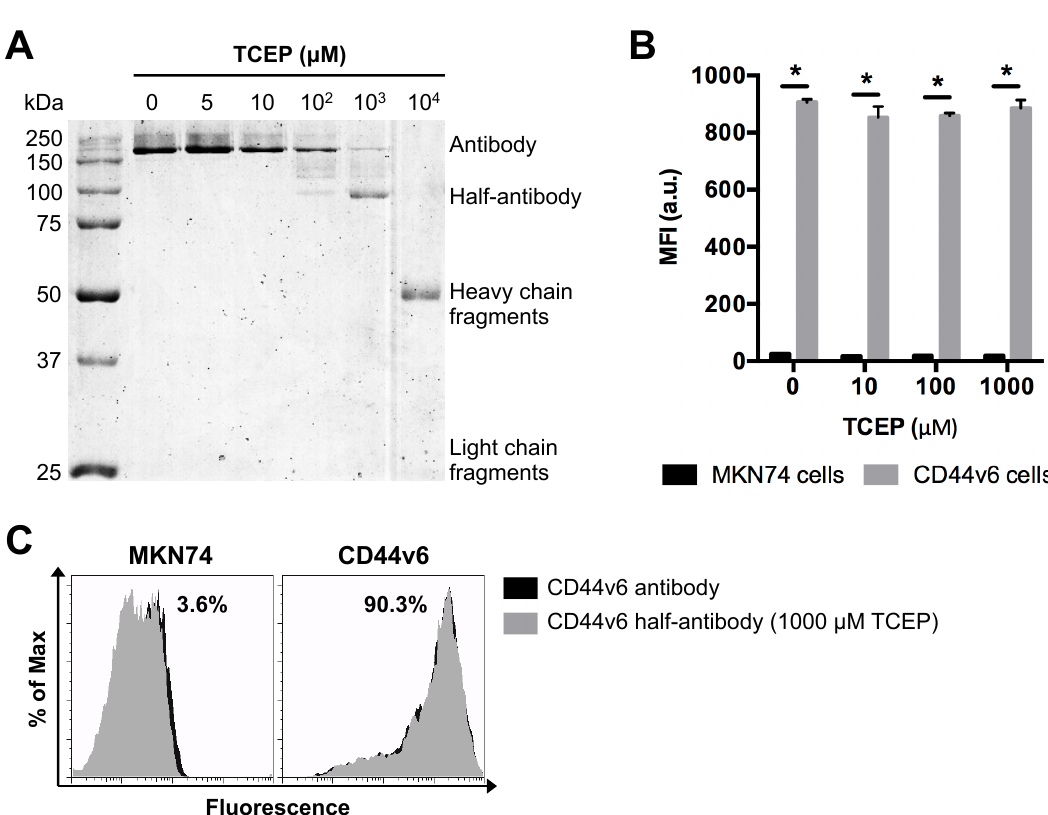
Figure 3. Selective TCEP-reduction of CD44v6 antibody generates half-antibody fragments that retain binding affinity to CD44v6-expressing GC cells without loss of selectivity. ( A ) SDS-PAGE analysis of mouse anti-human CD44v6 monoclonal antibody reduction products obtained using a range of TCEP concentrations. ( B ) Flow cytometry analysis of MKN74 and CD44v6 cell binding to CD44v6 antibody fragments reduced at different concentrations of TCEP. MFI = geometric mean fluorescence intensity; * p < 0.05. ( C ) Representative histograms of MKN74 and CD44v6 cells analyses by flow cytometry quantifying the binding affinity of CD44v6 antibody (clone M454) and 1000 µ M TCEP-reduced half-antibody fragments to CD44v6